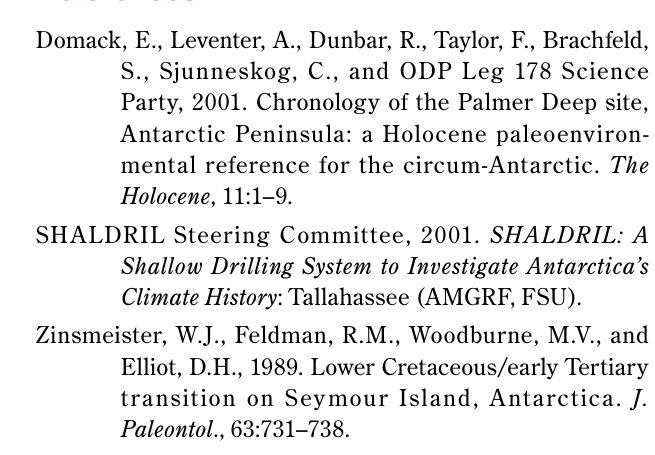
Fig. 1 photograph from http://www.polar.org/science/ marine/images/nbp_images/ship_cape_royds.jpg. Fig. 2 Photo by A.